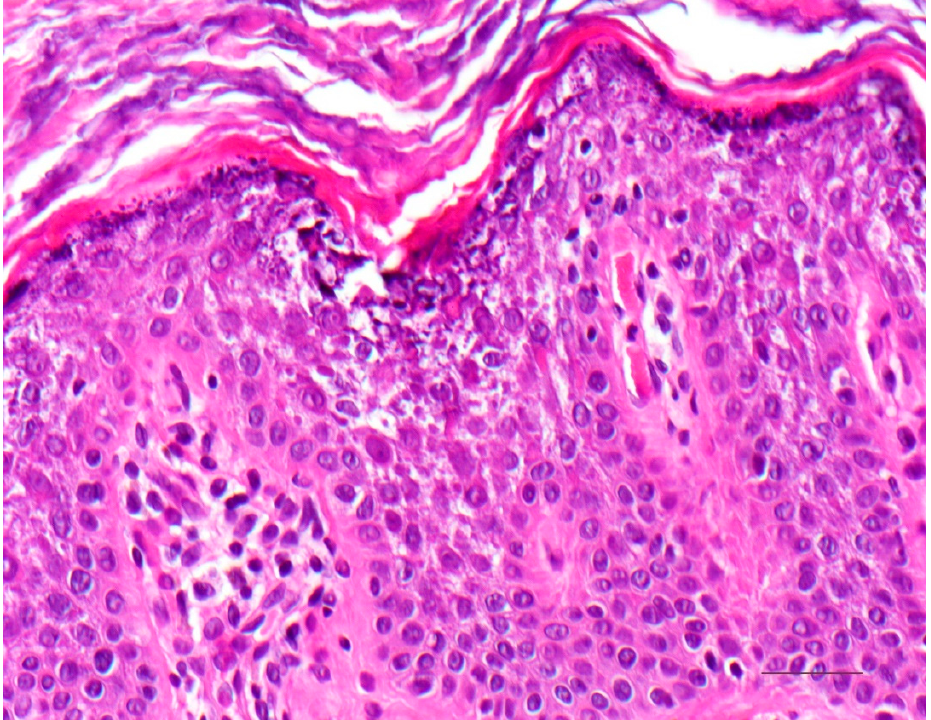
Figure 6. Epidermolytic ichthyosis. Acanthotic epidermis with massive orthohyperkeratosis. Suprabasal keratinocytes vacuolated with distinct hypereosinophilic granules and irregular keratohyalin granules. HE stain, bar = 50 µm.